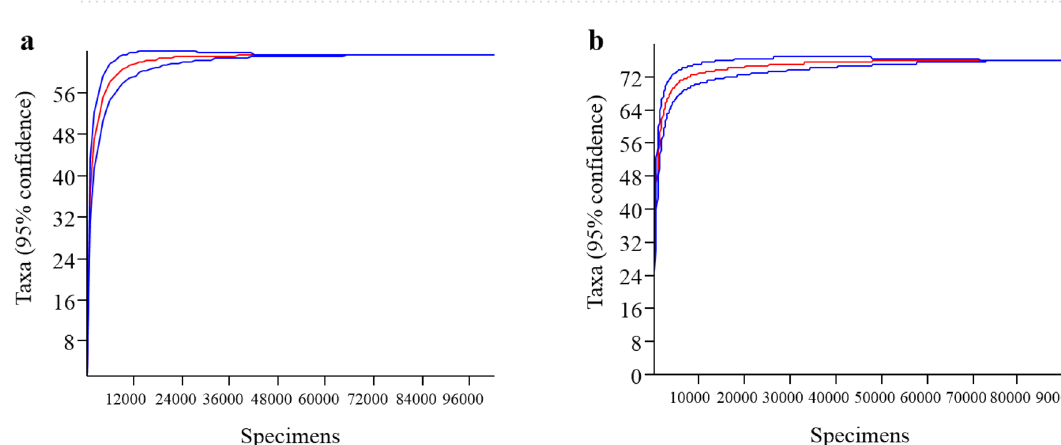
Figure 3. Rarefaction curves for samples from fungal assemblages present in the (a) air and (b) snow on Livingston Island, South Shetlands, Antarctica. Blue lines represent confidence limits inferred using bootstrap values calculated from 1,000 iterations using PAST, version 1.90 34